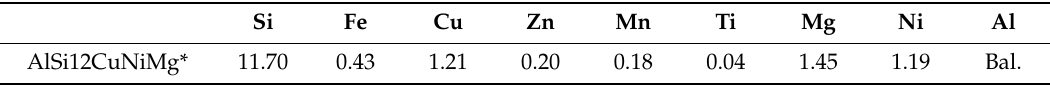
Table 1. Chemical composition of EN AB-48000 commercial alloy (PN-EN 1676—AlSi12CuNiMg). Si Figure 1. Microstructure of commercial AlSi12CuNiMg (AlSi12) alloy: (a) LM; (b) SEM.